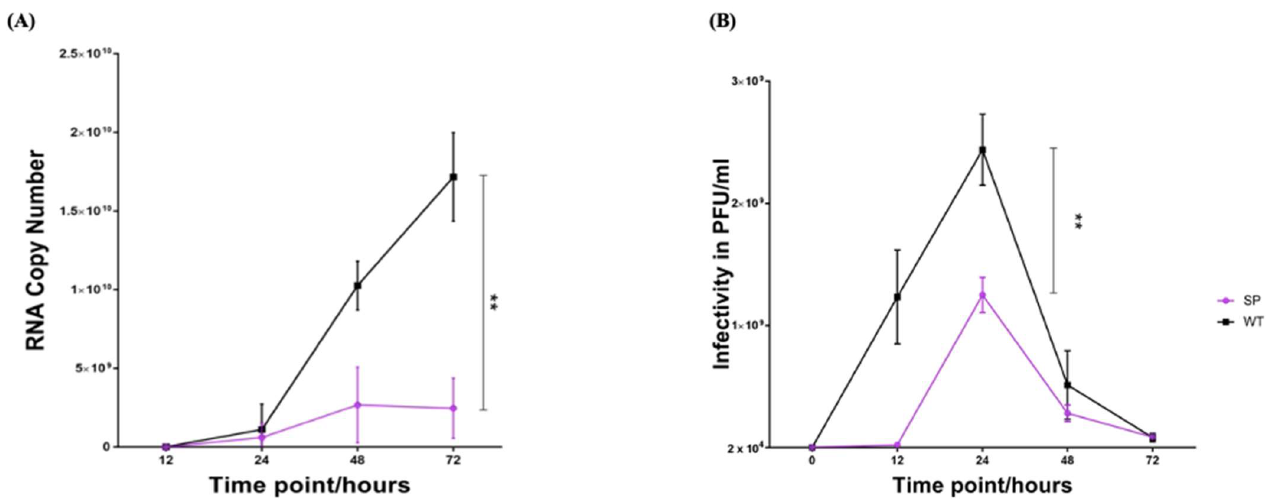
Figure 6. ( A ) Comparison of RNA replication rates and ( B ) plaque forming ability (PFU/mL) of EV-A71/WT (black) and EV-A71/SP (magenta) plated in RD cells. Viral supernatants were harvested from infected RD cells at 12, 24, 48 and 72 h.p.i. and subjected to plaque and qRT-PCR assays in triplicates to yield PFU/mL and RNA copy number, respectively. Statistical analysis, unpaired t -test, ** p <